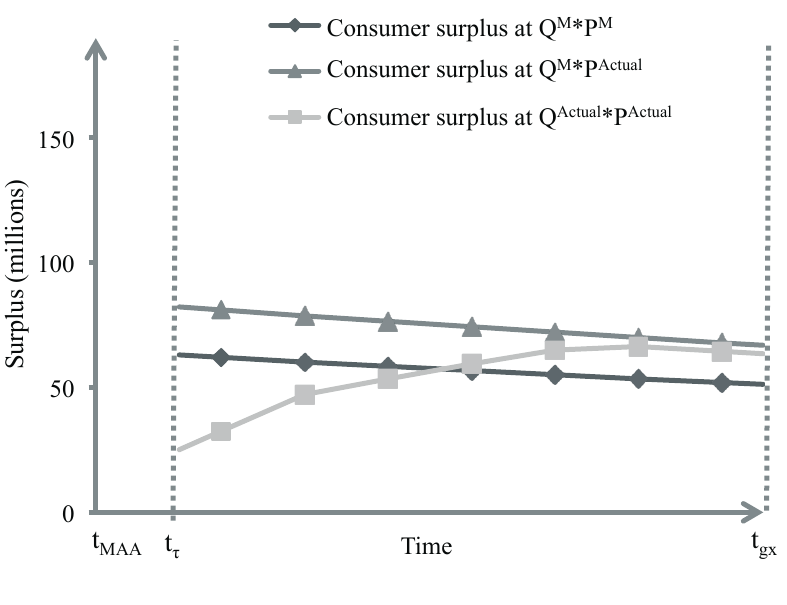
Figure 3b: Illustration of demand side policies impact on consumer surplus